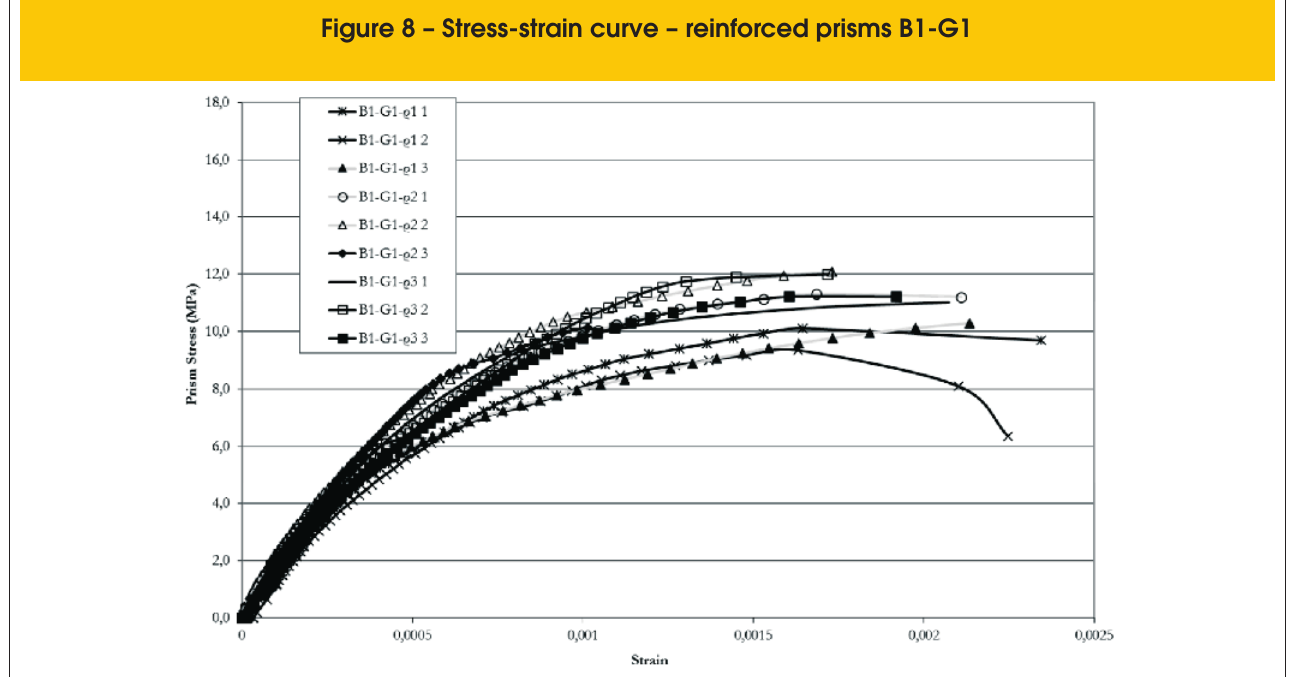
Figure 8 – Stress-strain curve – reinforced prisms B1-G1